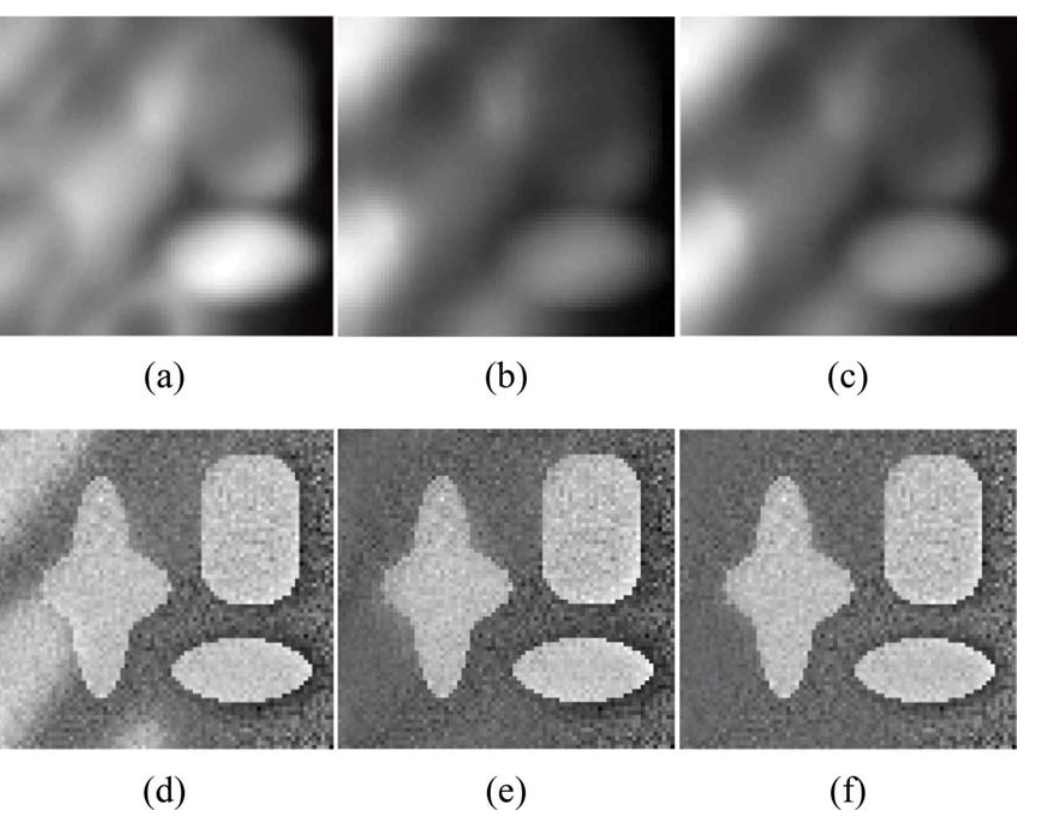
Fig 7. Comparisons of the bias field estimation and corrected image for Fig. 6 between Li ’ s model, LSACM and our model. (a), (b), (c) The estimated bias fields of Li ’ s model, LSACM and our model, respectively. (d), (e), (f) The corrected images of Li ’ s model, LSACM and our model,